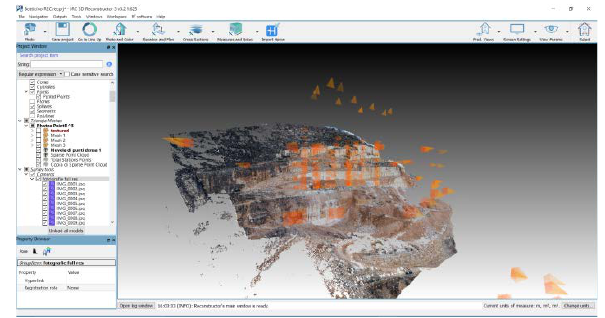
Figure 4. Final 3D mesh model obtained using Zephyr software